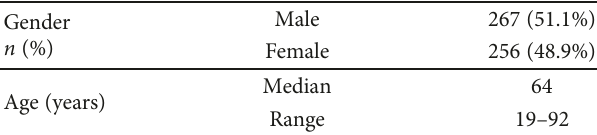
Table 1: Demographics of patients included in this study (664 polyps from 523 patients), all of whom had at least one polyp originally reported as either SSL/P or TSA.